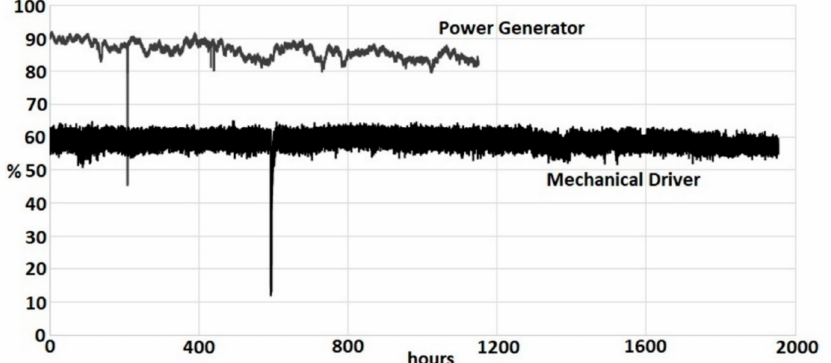
Figure 4. Measured power output during fouling conditions for engine operated as a mechanical driver and power